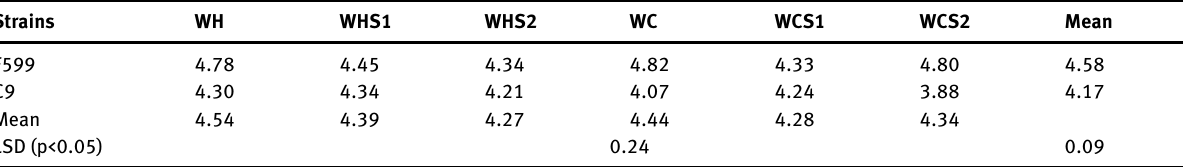
Table 3: Length of stipe of A. bisporus on various composts (cm) MeanWCS2WCS1WCWHS2WHS1WHStrains